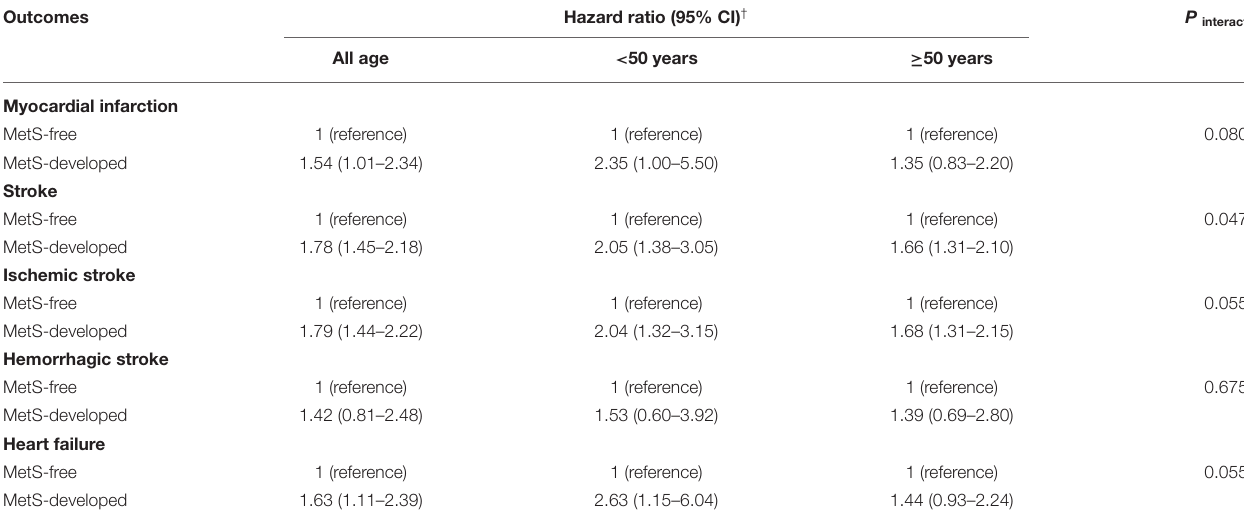
TABLE 3 | Hazard ratios and 95%CIs of the subtypes of cardiovascular disease in the MetS-developed group according to the age of MetS